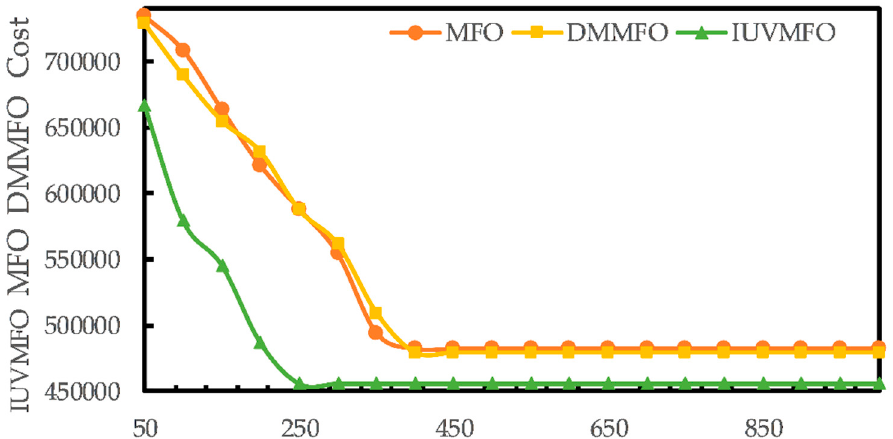
Figure 20. Curve diagram of algorithm test result under strong wind.